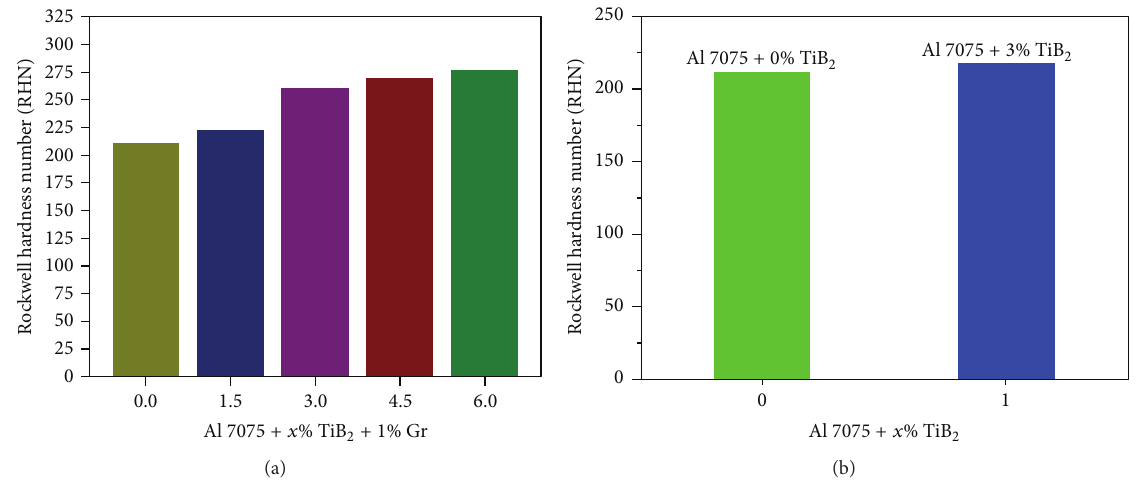
Figure 2: Rockwell hardness number for (a) Al 7075 + 𝑥 % TiB 2 + 1% Gr hybrid composites ( 𝑥 = 0, 1.5, 3, 4.5, and 6) and (b) Al 7075 + 𝑥 % TiB 2 monocomposite ( 𝑥 = 0 and 3).